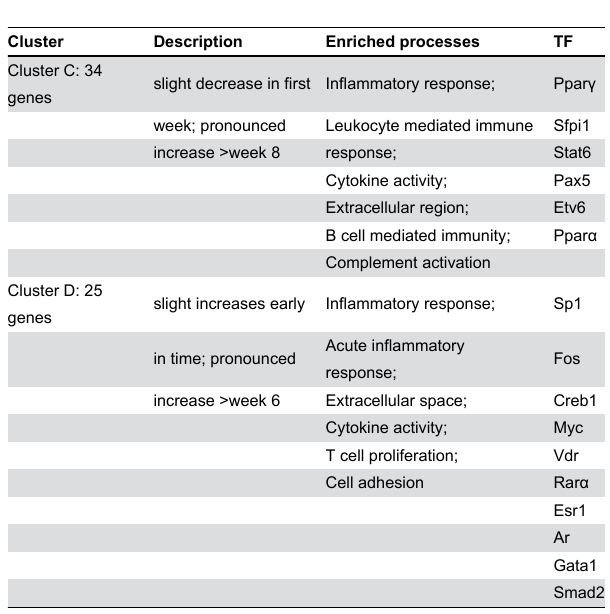
Table 2. Inflammatory genes with dynamic changes over